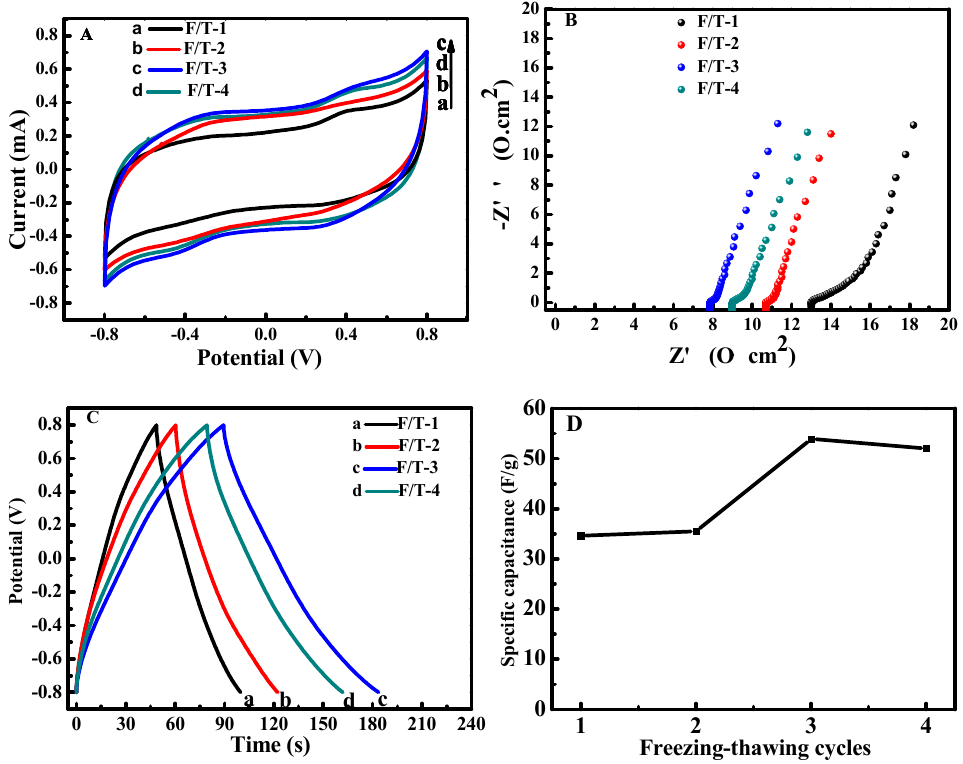
Figure 6. Cyclic voltammetry curves ( A ), electrochemical impedance spectra ( B ) of SSC-IL / PVA / H 2 SO 4 with various freezing-thawing cycles at 5 mV / s, galvanic charge–discharge curves ( C ), and the specific capacitance ( D ) at 1 mA / cm 2 . Table 2. Resistance values of SSC-IL / PVA / H 2 SO 4 underwent di ff erent freezing–thawing (F / T) cycles. F / T